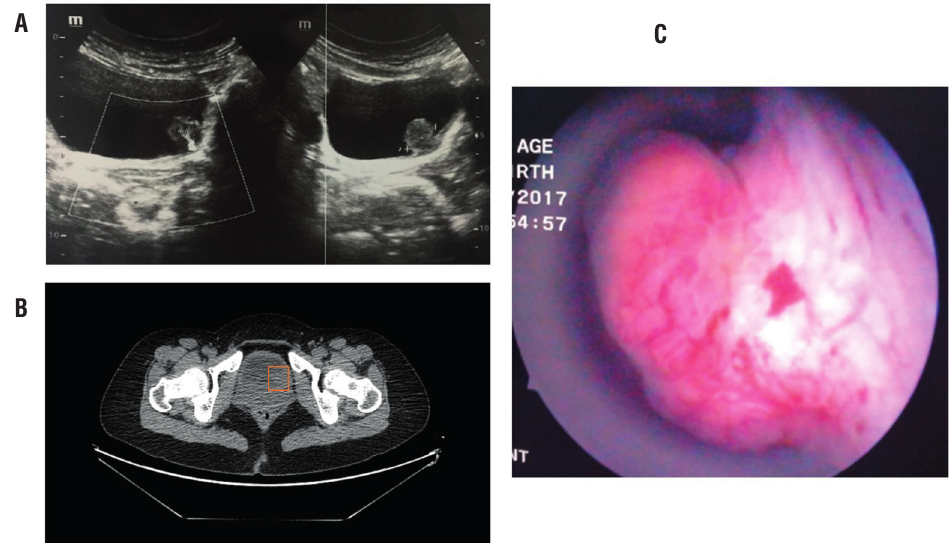
Figure 1 - Imaging and cystoscopy.